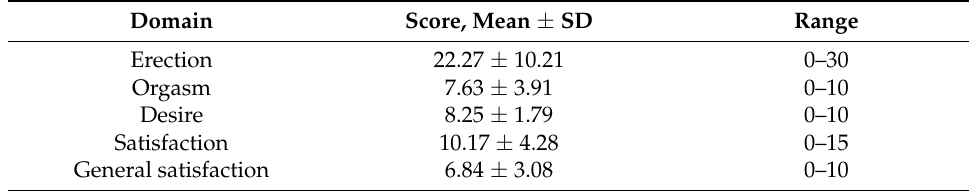
Table 4. International Index of Erectile Function 15 results.